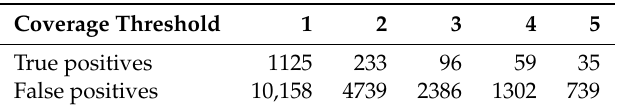
Figure 1. ( Left ) Number of variants as a function of the number of CirSeq reads supporting them. ( Right ) Schematic depiction of the procedure used to determine the sets of true and false positive variants from CirSeq data. Table 1. Number of false and true positive variants returned by the selection procedure of Figure 1 as a function of the coverage